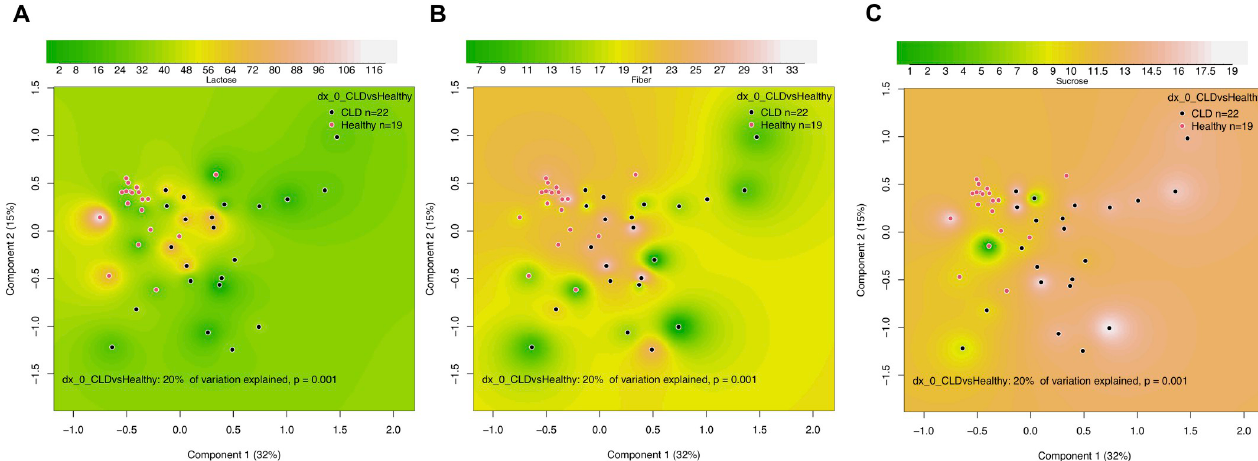
Fig 4. Effects of diet on fecal microbiota in congenital chloride diarrhea (CLD) and healthy controls. Shown are Principal-coordinate Analysis (PcoA) plots based on Bray-Curtis dissimilarities of the microbiota in relation to dietary (A) lactose (grams/day), (B) fiber (grams/day), and (C) sucrose (% of energy intake). The units of richness in PcoA plots are percentages.